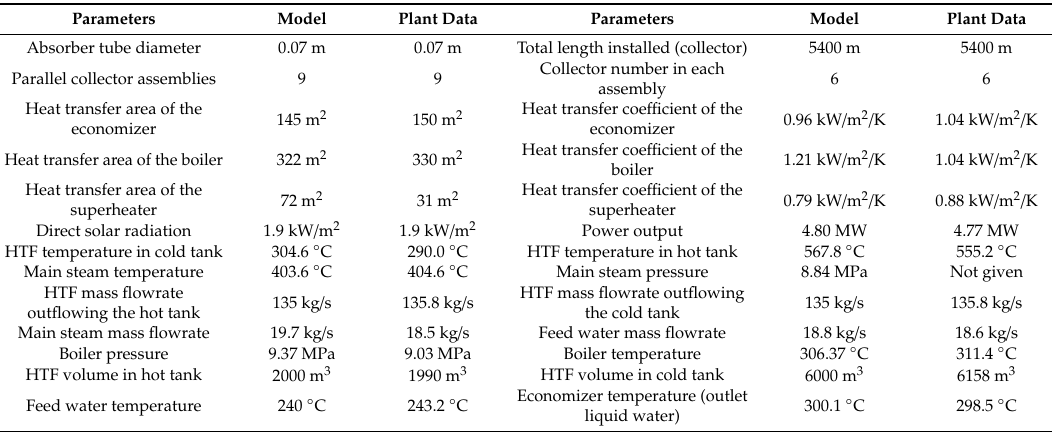
Table 1. Partial data of the model and the CSP plant reported in [15]. HTF: heat transfer